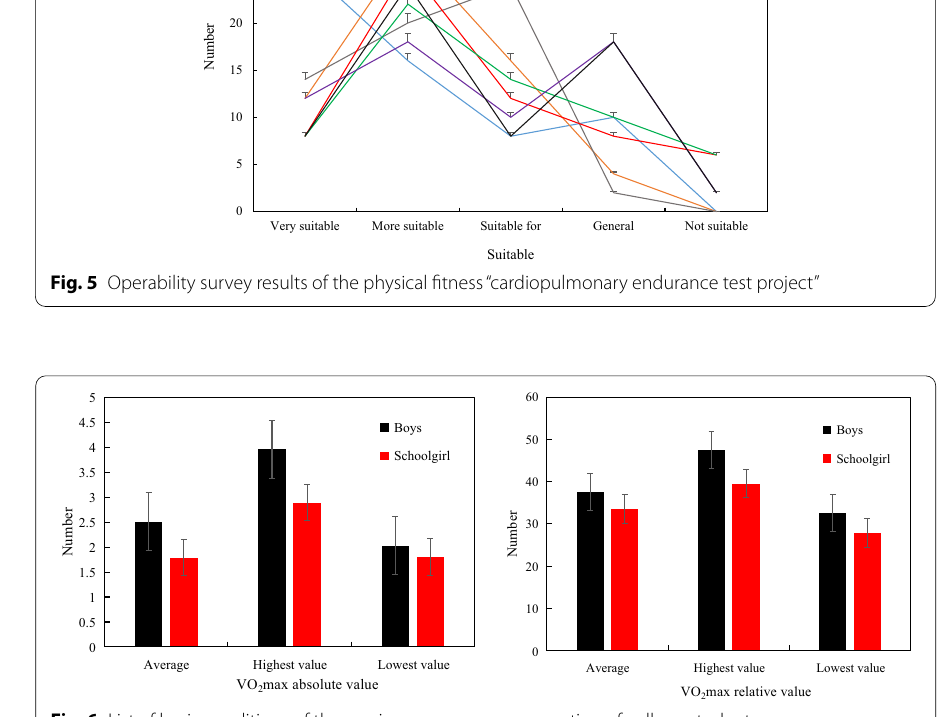
Fig. 6 List of basic conditions of the maximum oxygen consumption of college